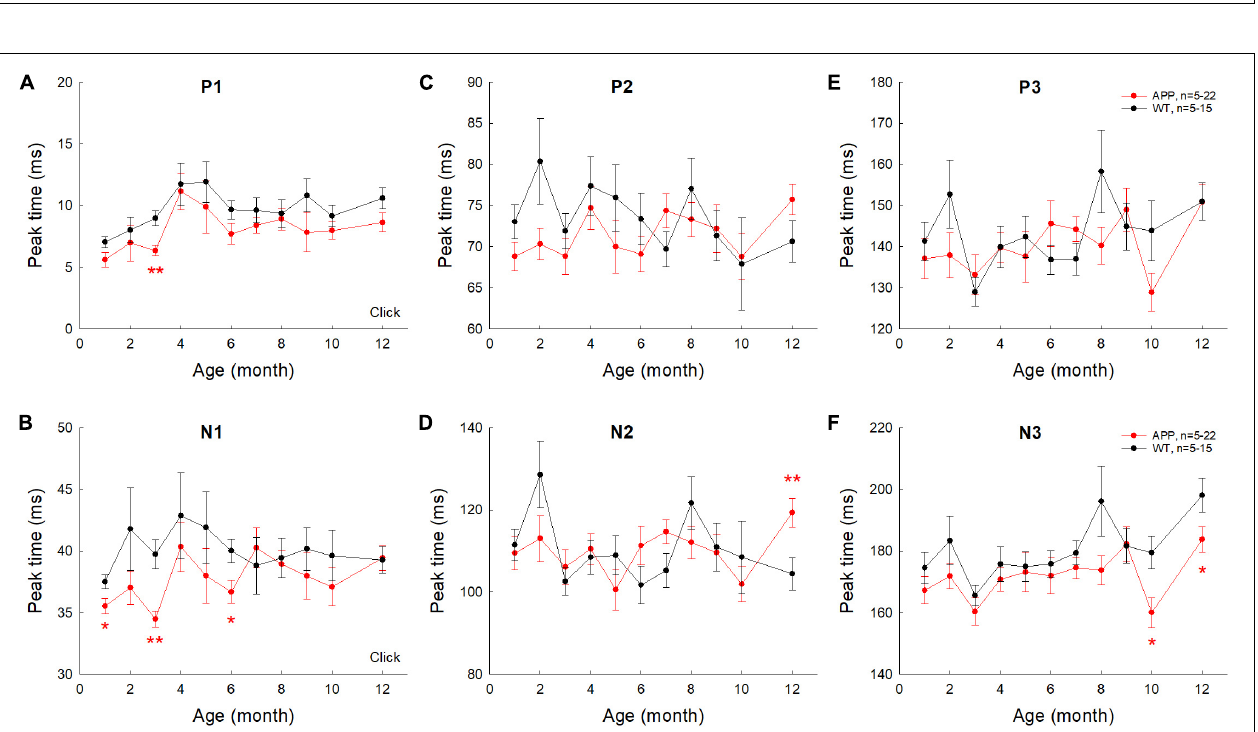
FIGURE 5 | Changes of AECP peak times in APP/PS1 AD mice with aging. Peak name is presented at the top middle place in each panel. N is the mouse number. The peak times in AD mice were compared with those in WT littermates at the same age. * p < 0.05, ** p < 0.01, t -test, two-tailed.